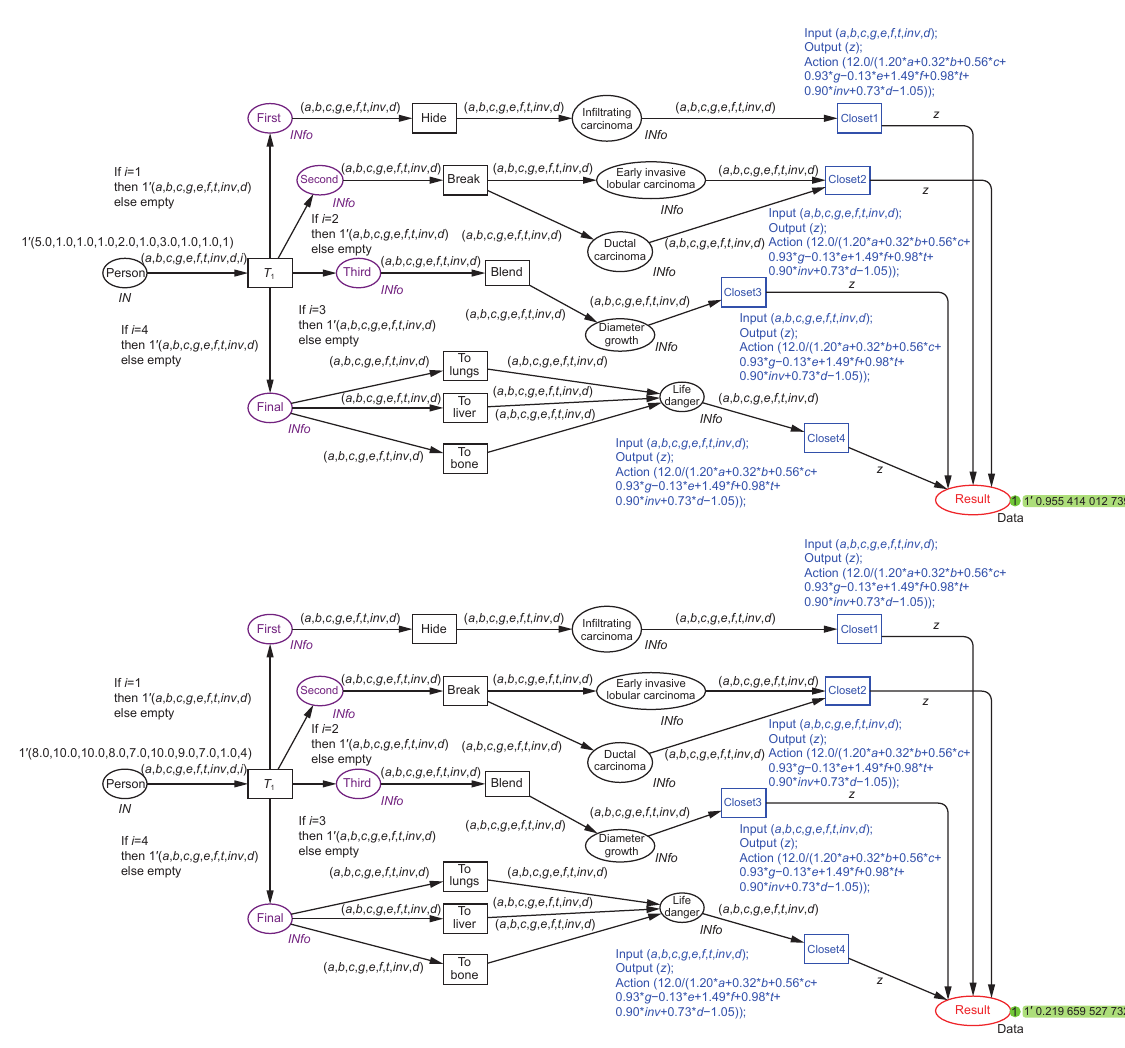
Fig. 6 Model modeling and analysis methods on the basis of CPN.